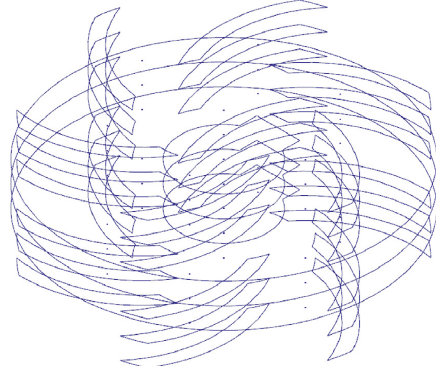
Figure 27: Slices of integrated substrate build